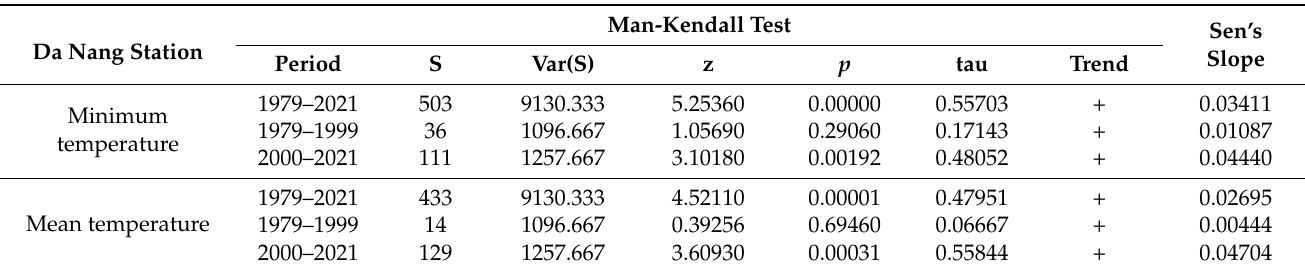
Figure 7. The maximum, minimum, and mean temperature in the Da Nang and Tam Ky meteorological stations from 1979 to 2021. p —statistically significant, R—Decreased/increased rates are the slopes of the linear regression. Table 3. Mann–Kendall test trend and Sen’s estimator results at the Da Nang meteorological station for Da Nang